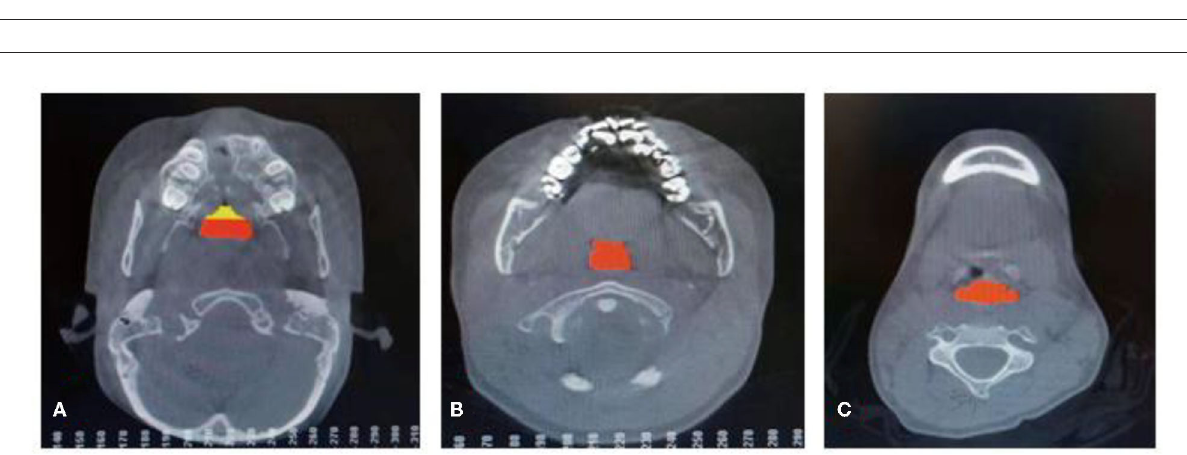
experimental group and the control group. The experimental group included 50 patients with unilateral complete cleft lip and palate after velopharyngeal closure, and the control group included 50 patients with non-left lip and palate. The age of these 100 patients ranged from 9 to 11 years, and the gender ratio of the experimental group was similar to that of the control group. The p -value of each group was higher than 0.05, which means their variances are homogeneous. All the samples were analyzed with the variance analysis approach. The results show that changes in the airway volume were statistically significant ( p_value < 0.05) between the experimental group and the control group. The control group’s measurements, including total airway volume, airway volume of the palatopharyngeal segment, and airway volume of the glossopharyngeal segment,